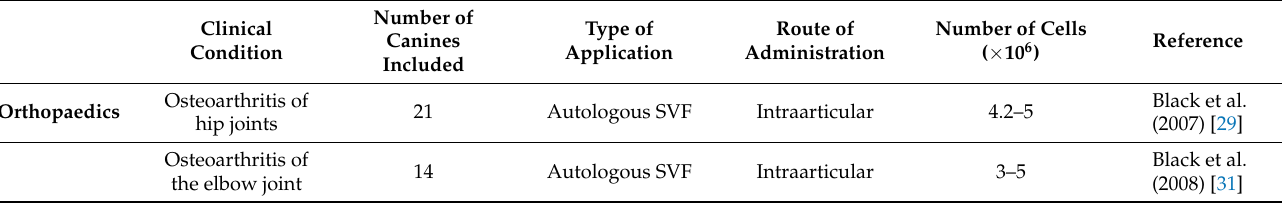
Table 1. Studies of canine adipose-derived mesenchymal stem cells (ASCs) and stromal vascular fraction (SVF) applied in canine pathological